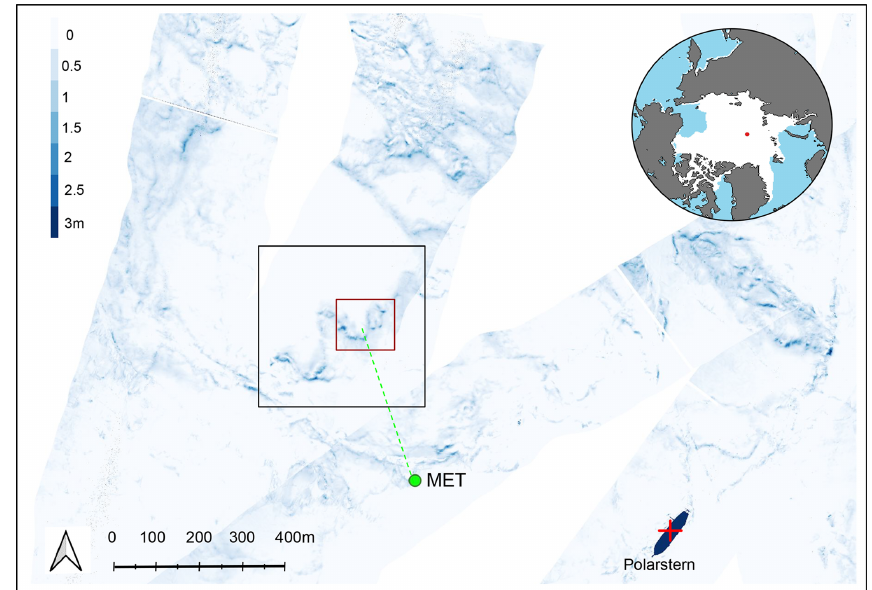
Figure 1. Aerial laser scan (ALS) of the sea ice floe taken on 12 November 2019 during a helicopter flight. The black rectangle pinpoints the zone covered by the terrestrial laser scans (TLSs) which were used in the simulations. More specifically, the sea ice area framed within the red rectangle served as a base for the snowBedFoam 1.0. computational domain. The green dot highlights the position of the MOSAiC meteorological station where wind measurements were taken. The red cross points out the position of the Polarstern icebreaker (Alfred- Wegener-Institut Helmholtz-Zentrum für Polar- und Meeresforschung, 2017). The map in the top right corner shows the position of Polarstern on the day of the ALS